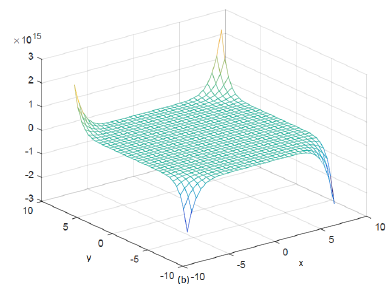
Figure 7: Plotting of (a) M-polynomial and (b) NM-polynomial of convolutamide